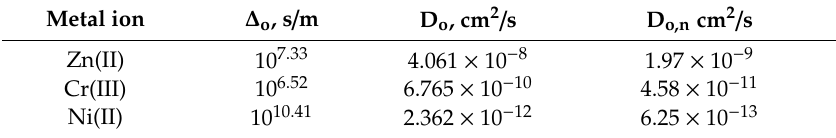
Table 6. Values of diffusion coefficients for metal ions transport across PIMs doped with EDAB- acac. Metal